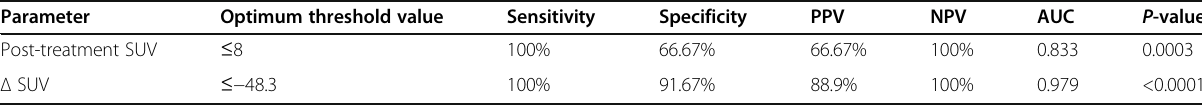
Table 4 The sensitivities, specificities, positive predictive values (PPV), negative predictive values (NPV), area under the curves (AUC), and P -values of the optimum threshold values of the post-treatment SUV and SUV for differentiation of responders from non-